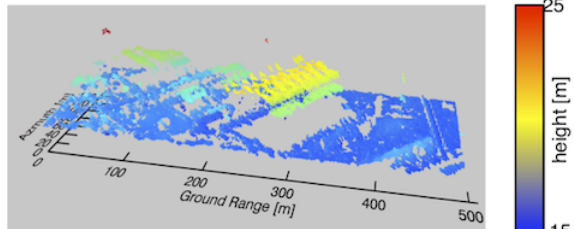
Figure 8: Reflectivity reconstruction after using the TomoSNI ap- proach. Color corresponds to the height of the scatterers. Data are represented in ground range geometry.